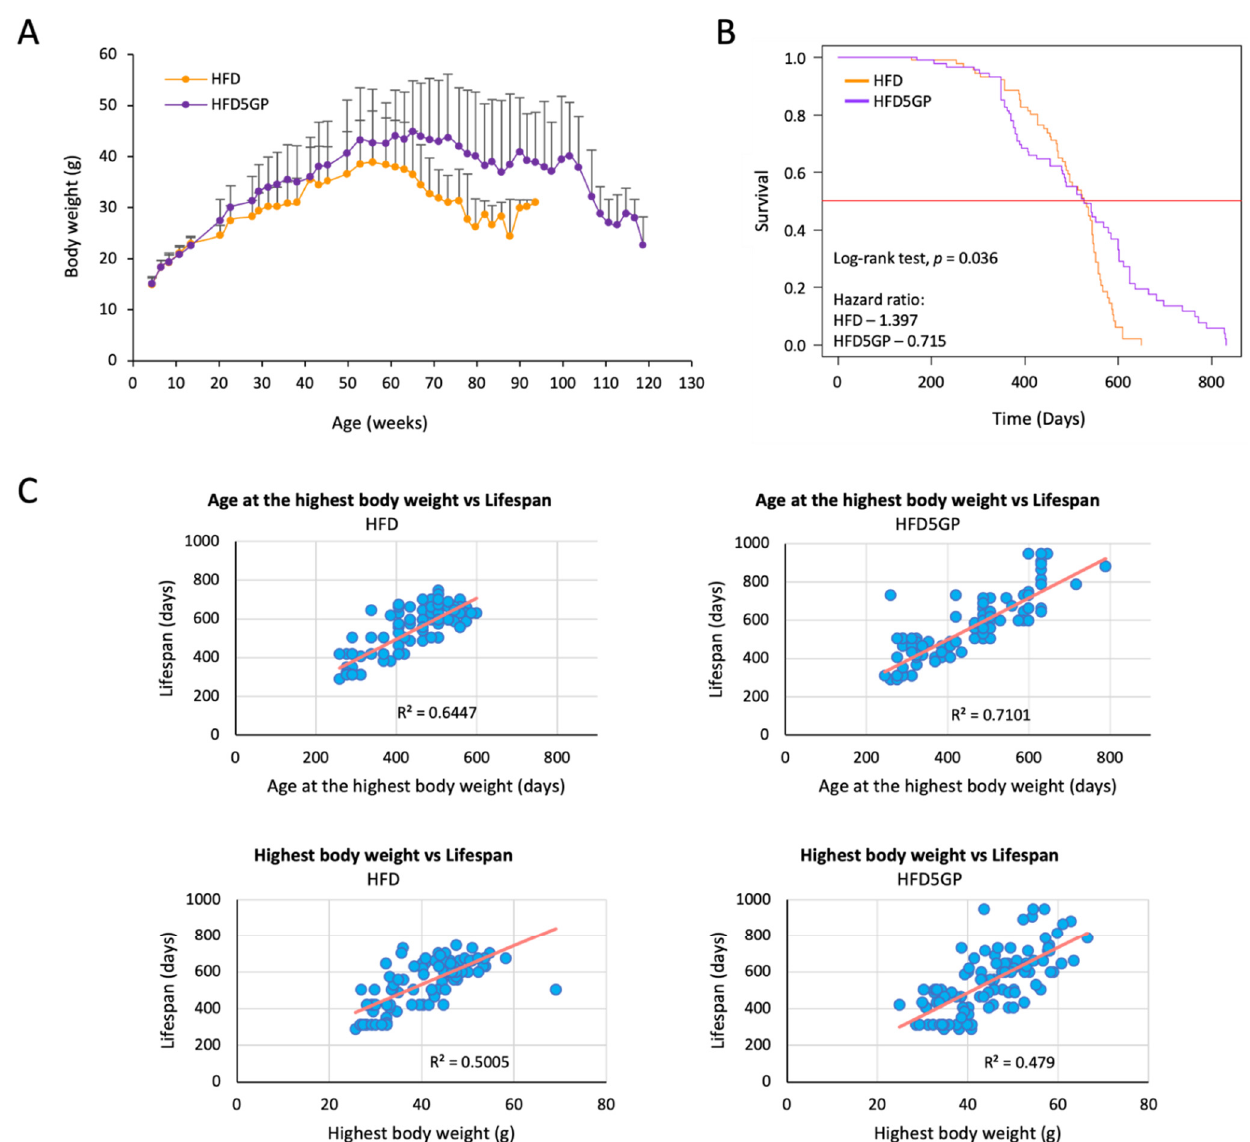
Figure 2. Grape powder supplementation of a high-fat diet affects temporal weight loss and increases the lifespan of C57BL/6J mice. ( A ) At 14-weeks-of-age, mice were divided into two groups ( n = 100 per group), and diet was changed from the STD to either the high-fat diet (HFD) or the high-fat diet supplemented with 5% grape powder (HFD5GP) for the remainder of their lifespan. Body weight was recorded every two weeks and recorded as mean ± SD. ( B ) Kaplan-Meier plot showing the survival of mice provided with the HFD or the HFD5GP. Survival was enhanced with the group provided with the HFD5GP ( p = 0.036; log-rank test). The hazard ratio of the HFD group was 1.397 (95% CI, 0.99–1.96), whereas the hazard ratio for the HFD5GP group was 0.715 (95% CI, 0.507–1.009). ( C ) Correlation plots showing the age at highest body weight versus lifespan for individual mice (upper panels), and the highest body weight attained by individual mice versus lifespan (lower panels).